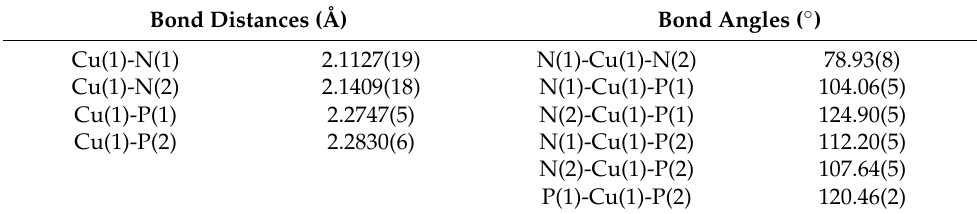
Table 2. Selected structural characteristics of compound 1.